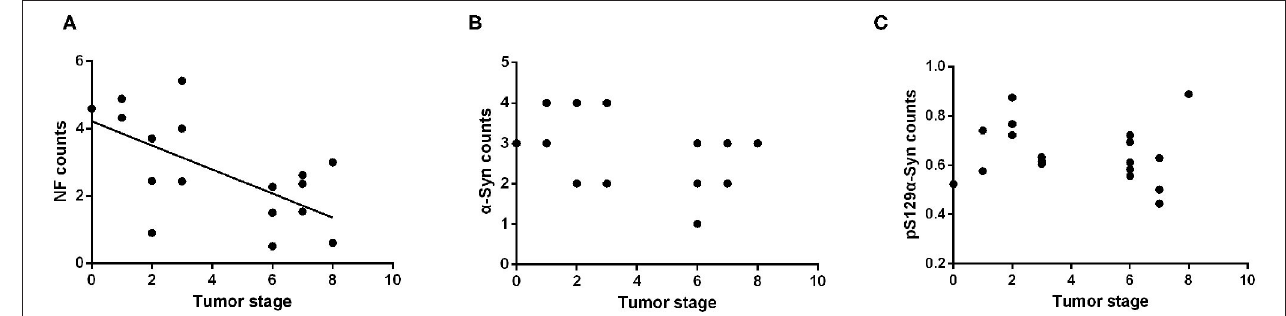
FIGURE 5 | Correlation analysis between the α -Syn pathology of the ENS and tumor malignancy. (A) Scatter plot of p S129 α -Syn immunoreactive signals within the myenteric plexus with tumor malignancy; a negative correlation was observed (Pearson correlation, R = − 0.522, p = 0.022). (B) Scatter plot of α -Syn immunoreactive signals within the myenteric plexus with tumor malignancy; no significant correlation was observed (Spearman correlation, p = 0.095). (C) Scatter plot of p S129 α -Syn immunoreactive signals within the myenteric plexus with tumor malignancy; no significant correlation was observed (Pearson correlation, p =